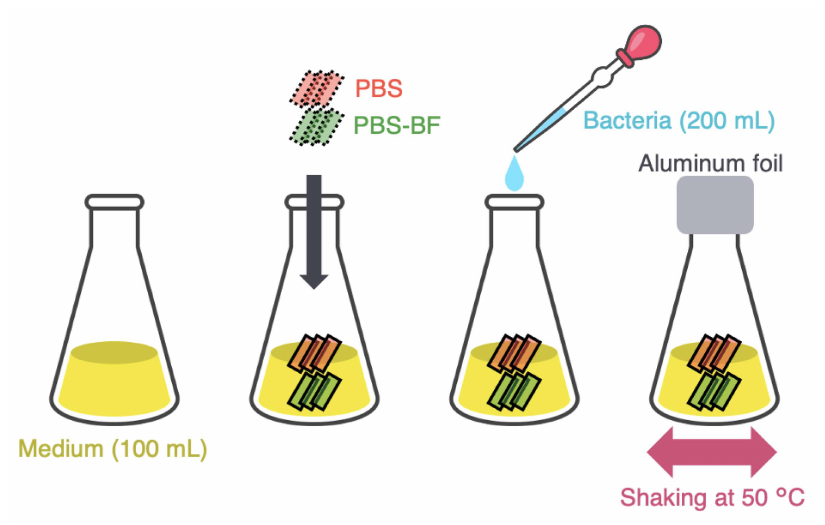
Figure 2. Schematic illustration of the method used in the microbial degradation test of PBS and PBS–BF